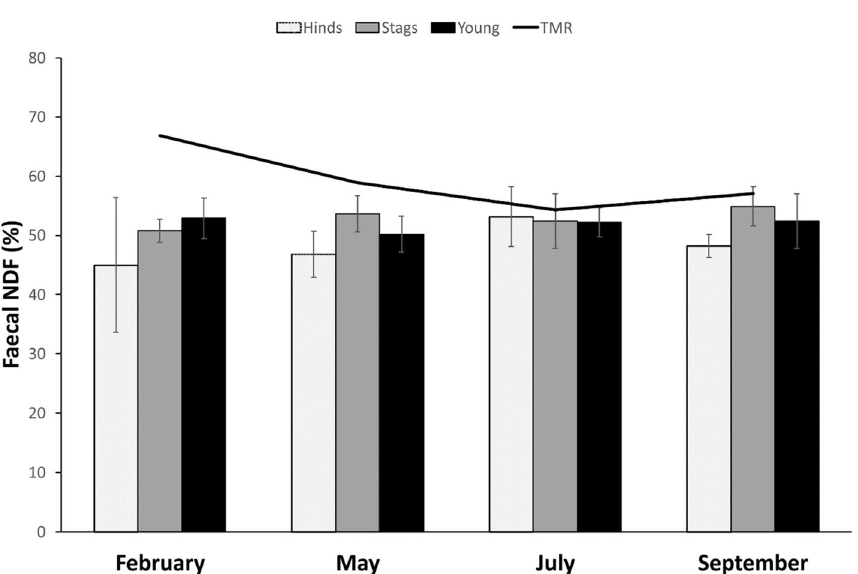
Figure 2. Faecal NDF content for red deer hinds, stags, and young along the 4 studied periods (seasons). The line indicates the percentage of NDF found in the feedstuff ( TMR total mixed ration) that animals were provided during the